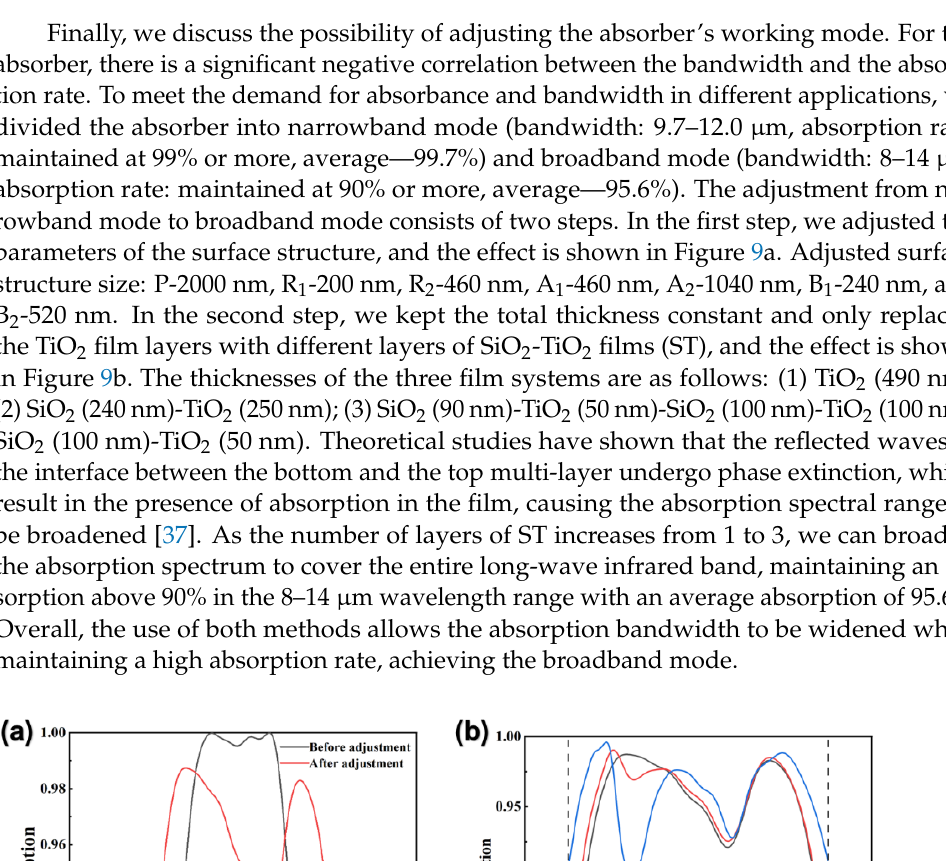
Figure 8. ( a ) Absorption spectrum under different polarization angles. ( b ) Absorption spectrum un- der different incident angles (TE wave). ( c ) Absorption spectrum under different incident angles (TM wave).